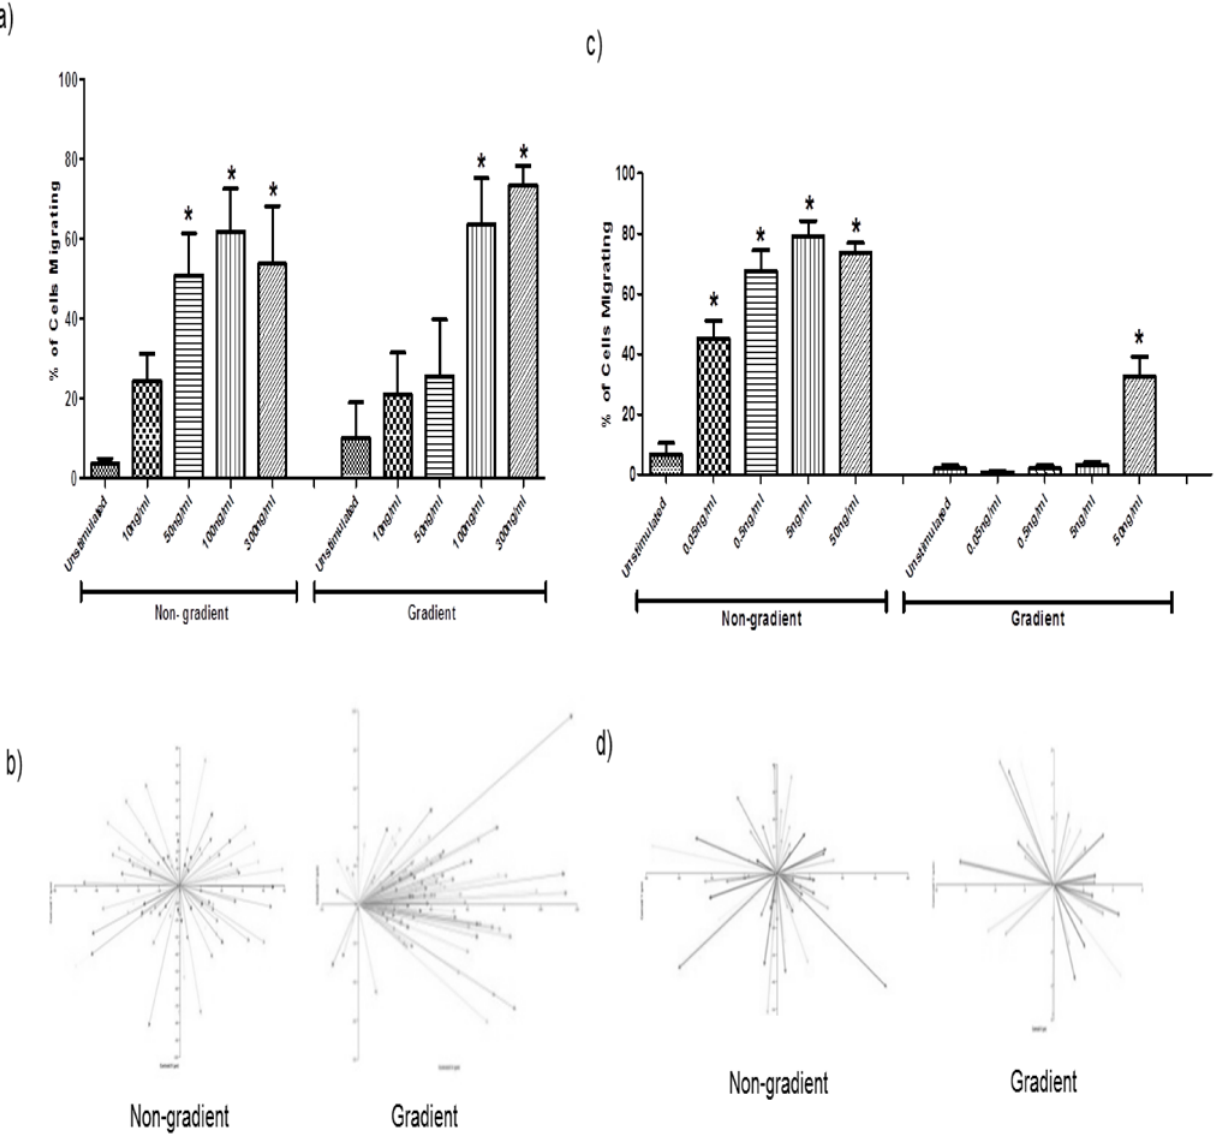
Fig 1. Neutrophil migration is dose dependent in both the gradient and non-gradient assays. a) migration in response to CXCL8, * significantly greater as compared to control cells, p < 0.05, n = 3 except for non gradient control and 100ng/ml where n = 5. b) The direction of movement for each neutrophil in the non gradient and gradient assay in response to 100ng/ml of CXCL8 is illustrated in the vector diagrams which show chemokinetic migration in the non- gradient assay and a chemotactic pattern of migration in the gradient assay. c) Neutrophil migration to GM-CSF is dose dependent in both the non gradient and gradients assays. * significantly greater as compared to control cells, p < 0.05, n = 3 except for gradient control and 50ng/ml where n = 7 and 6 respectively. d). The direction of movement for each neutrophil in the non gradient and gradient assay in response to 50ng/ml of GM-CSF is illustrated in the vector diagrams, These show that the pattern of migration to GM-CSF was chemokinetic in both the gradient and non-gradient